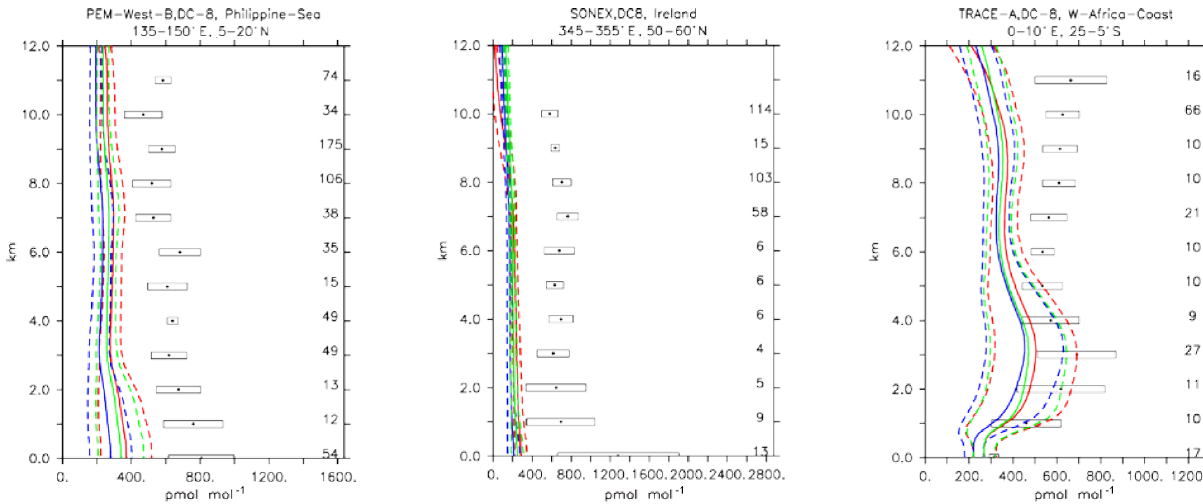
Figure 16. Comparison of simulated C 2 H 6 vertical profiles by using the CBA (red), MOC (blue) and MOZ (green) chemistry versions against aircraft data (black). Line styles and symbols have the same meaning as in Fig.